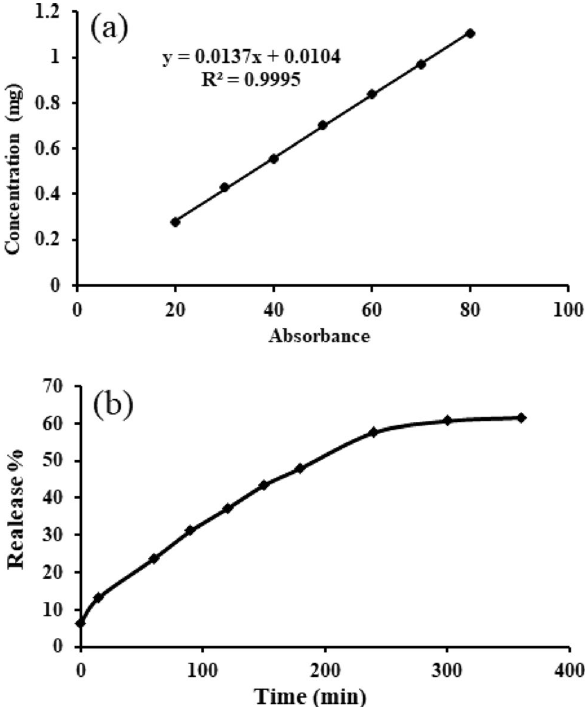
Figure 3. Standard calibration curve of the crocin ( a ) and the pattern of drug release of the niosomal formulation contain